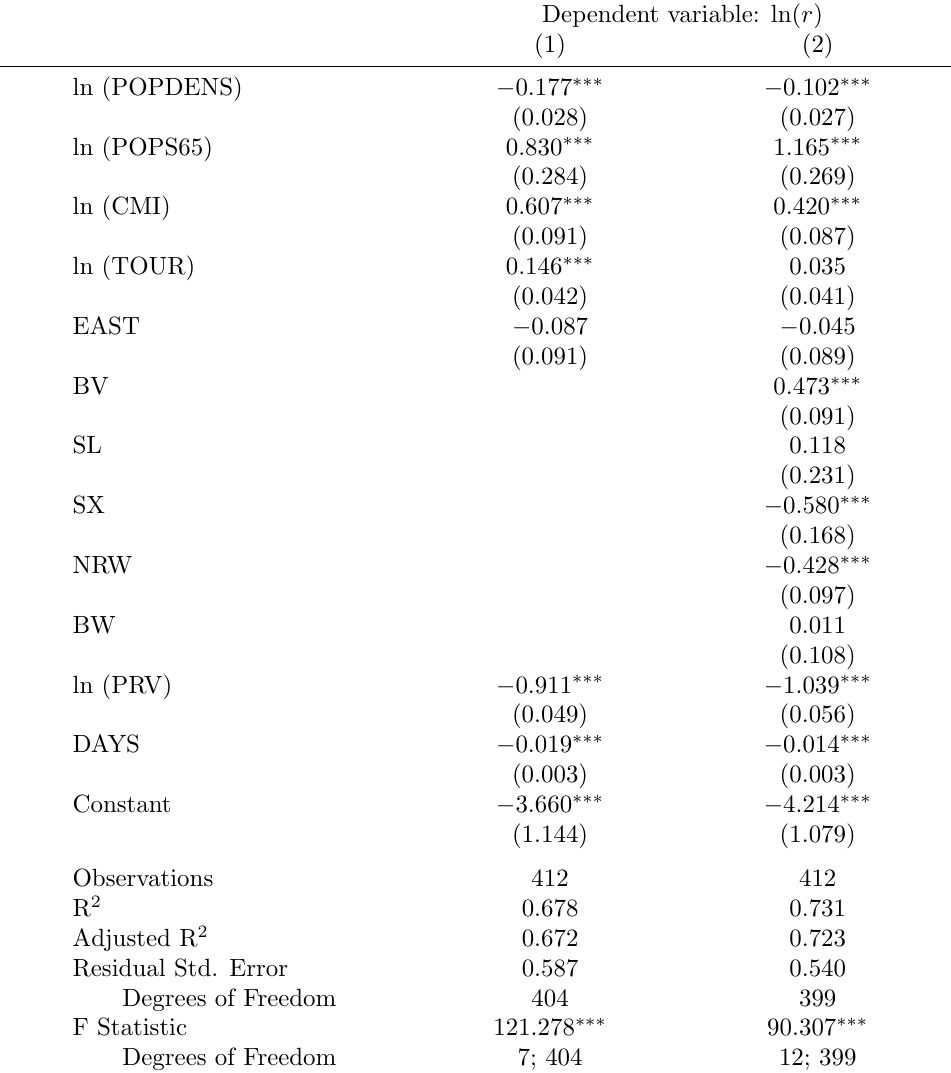
Table 7: Estimation results for the growth rate model